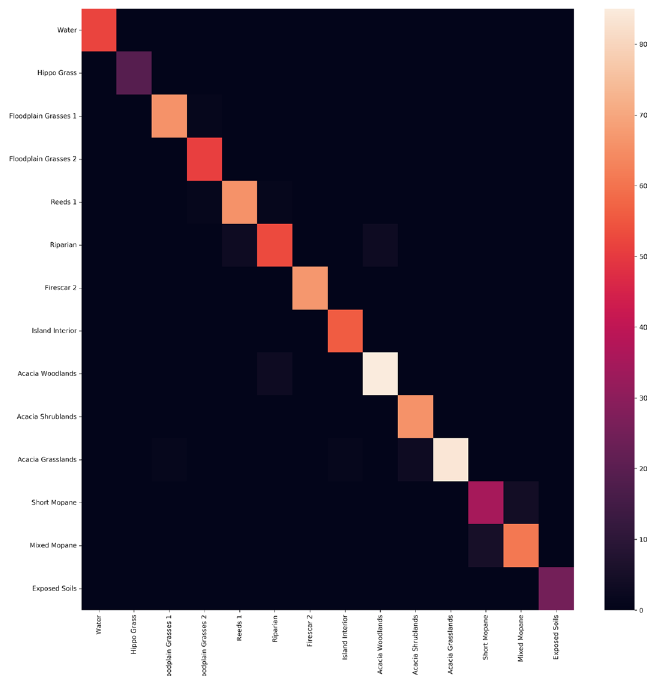
Fig. 13 Botswana Confusion Matrix for PCA 30 CEU-Net no patching with a 75%/25% Training/Testing